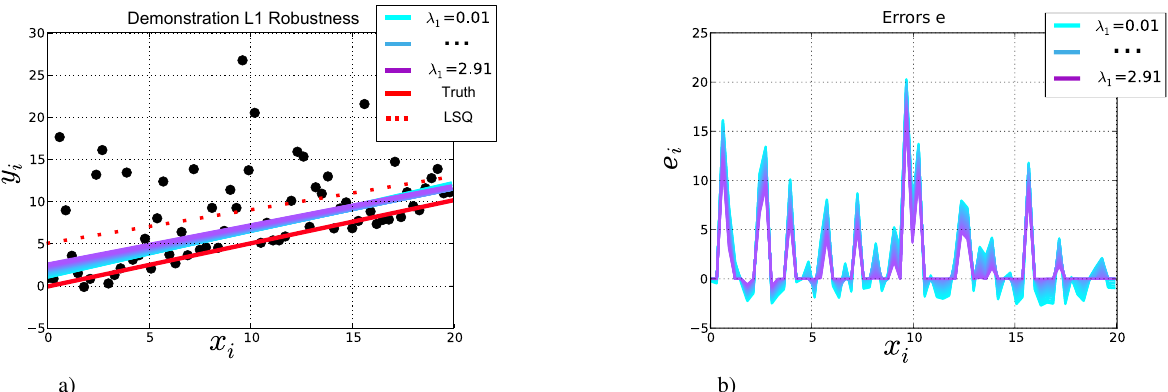
Figure 2: Robust l 1 regression, 20 experiments with varying λ . Compared to the l 2 regression (LSQ, red dotted line) the estimated parameters are closer to the ground-truth (bottom solid red line). b) The error value e i for every sample x i . Increasing the weighting λ on k e k 1 increases its sparsity.